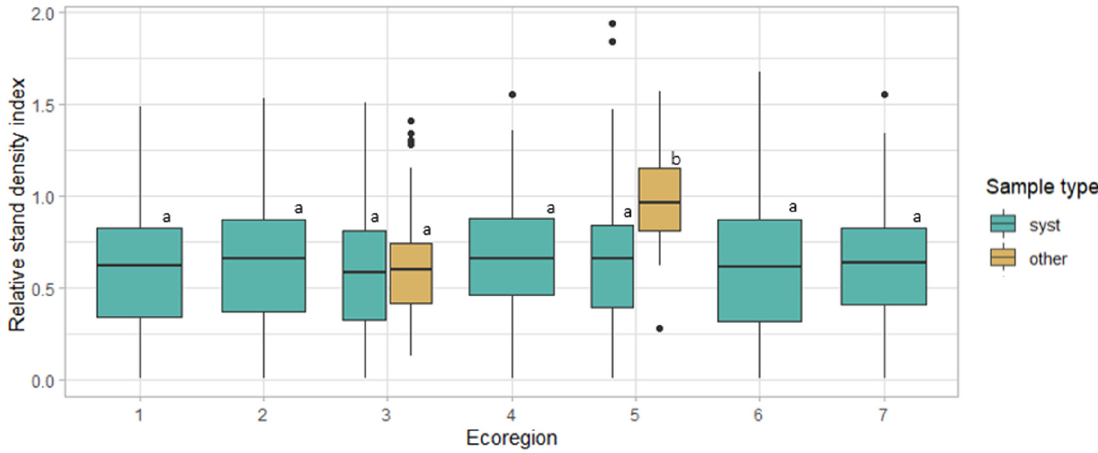
Figure 5. Relative stand density index of plots depending on the ecoregion (1 to 7) and the sample type (systematic “syst” or other) (N = 6,789). Different letters indicate statistically different RSDI’s based on Tukey-HSD post hoc tests.